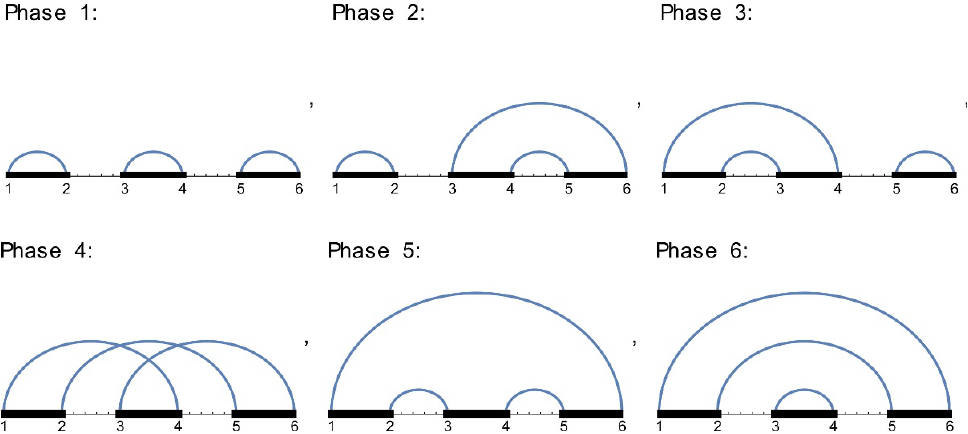
Figure 18 . 3! = 6 preliminary con(cid:12)gurations for n = 3. Note that the 4th con(cid:12)guration is likely unphysical. According to the nomenclature of [80], the phase 6 is referred to as engulfed phase. from the physical phases such as